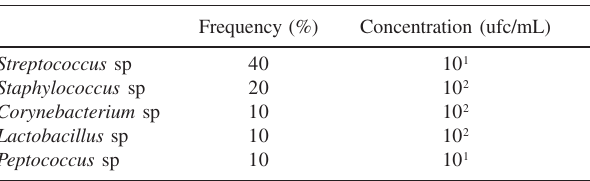
Table 2 - Frequency and concentration of microorganisms in the esophagus Frequency (%) Concentration (ufc/mL) Streptococcus sp 40 10